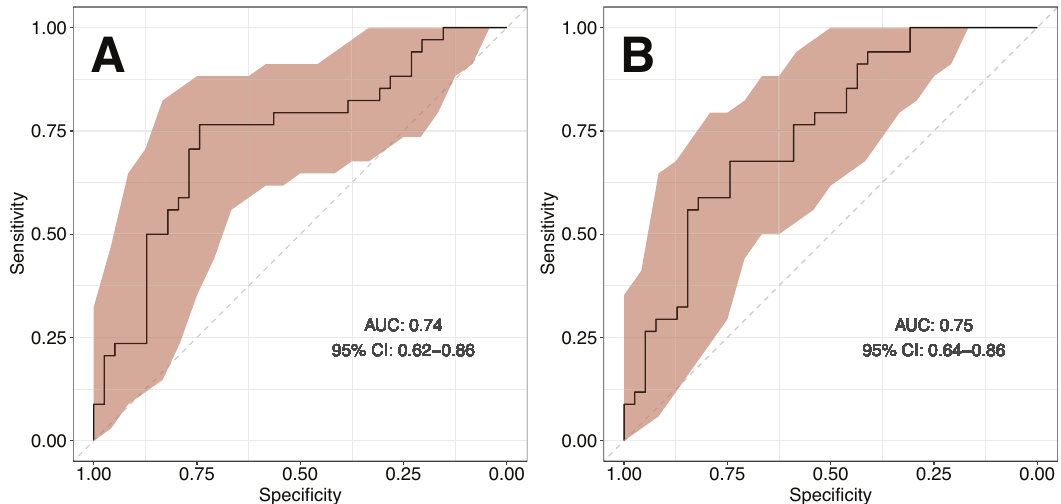
Fig. 3 Validation of the diagnostic model in an independent cohort of 34 fi rst-onset drug-naïve schizophrenia patients and 39 healthy controls. Shown are receiver operating characteristic curves (ROC) of the three-biomarker model ( A ) and two-biomarker model ( B ), with sensitivity con fi dence intervals (CI) marked in red. AUC area under the ROC curve. from recent-onset schizophrenia patients and healthy controls, and the levels of selected disease-related analytes were compared between the groups. Expression of three PBMC epitopes, monocyte GLUT1 and T helper cell CD36 and IR, was found to be signi fi cantly altered in schizophrenia. A diagnostic model based on the two most robust biomarkers, monocyte GLUT1 and T helper cell CD36, demonstrated good predictive performance when separating schizophrenia patients from healthy controls in three independent cohorts, as well as from patients with other relevant neuropsychiatric disorders, including autism spectrum condition, bipolar disorder and major depressive disorder. Downregulation of GLUT1 in monocytes may indicate impaired energy metabolism in schizophrenia. GLUT1 is a protein respon- sible for glucose transport across cell membranes. Unlike other GLUT proteins, GLUT1 is regulated by circulating blood glucose rather than insulin [27]. Since glucose starvation is known to upregulate GLUT1, lower GLUT1 expression in monocytes may be linked to hyperglycaemia and other glucoregulatory abnormalities which are frequently observed in schizophrenia patients [22, 28].